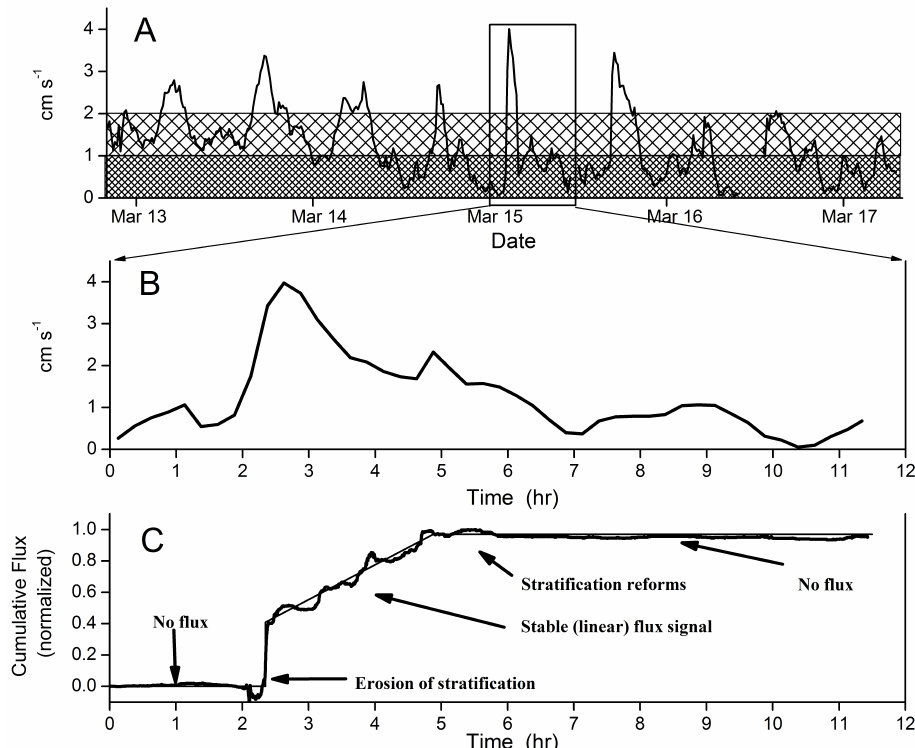
Fig. 2. (A) shows the mean current velocity measured 22cm below the ice-water interface over 4.5d. The dark shaded region ( < 1cms − 1 ) represents conditions where density stratification in the water column appeared to be persistently present while the lightly shaded region (1– 2cms − 1 ) represents conditions where stratification was occasionally observed. The presence of stratification was evaluated by examining the mean velocity and the stability and linearity of the cumulative flux signal. (B) shows a 12h segment of the velocity data in (A) . (C) shows that during this segment the flux signal was strongly dependent on current velocity. The magnitude of the vertical rise at hour 2.3, when stratification eroded due to an increase in velocity, was not indicative of any true flux and therefore was not included in the flux